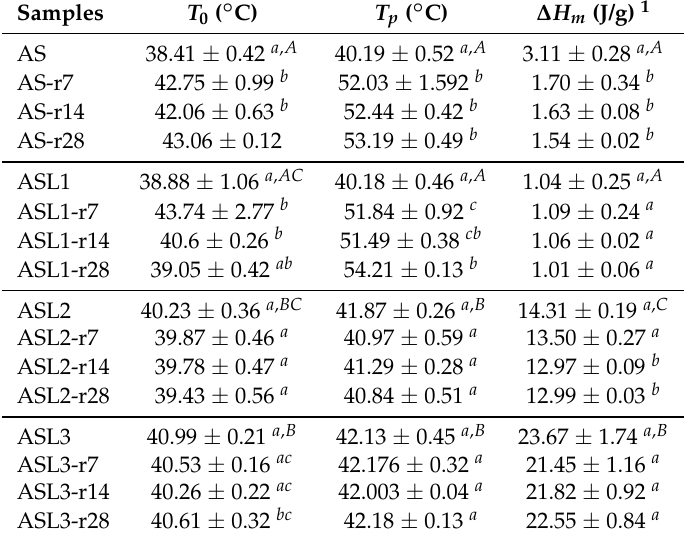
Table 4. Thermal characteristics of fresh starches (AS, ASL1, ASL2 and ASL3) and retrograded starches at different storage durations (r7, r14 and